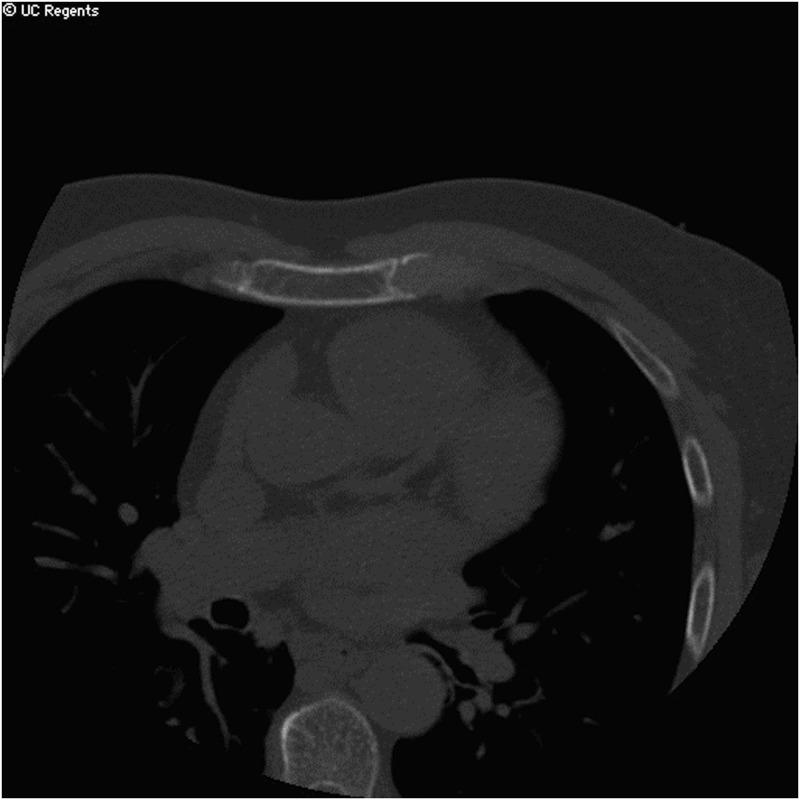
CAC EBCT of a subject with CAC score of 0.Abbreviations: Coronary artery calcium (CAC), External beam computed tomography (EBCT).